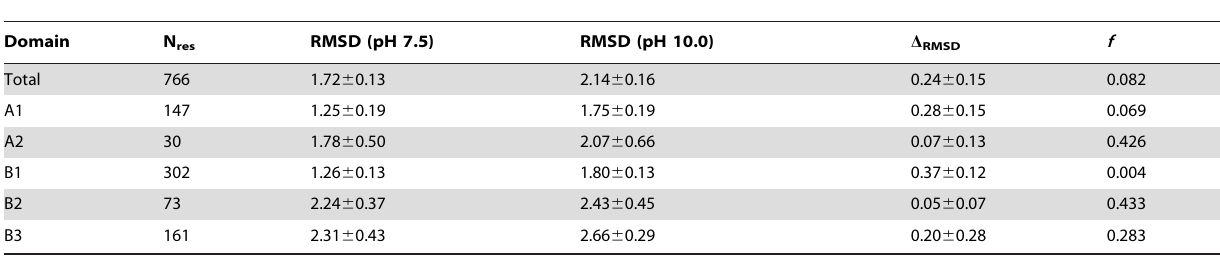
Table 1. Structural stability of the wild type Ec PA at pH 7.5 and 10.0.